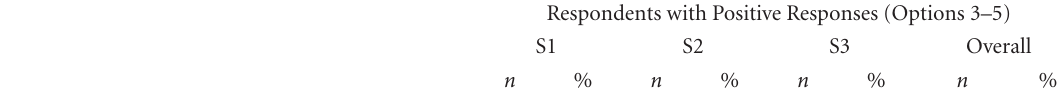
Table 4: Summary of the students’ perception towards the program e ff